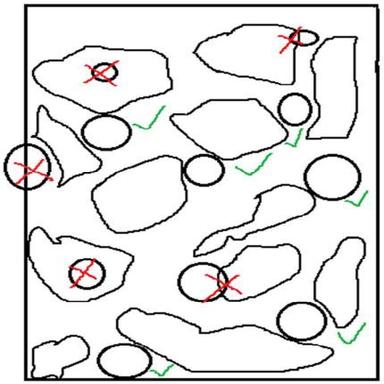
Schematic visualization of the measurement procedure of void size distribution.